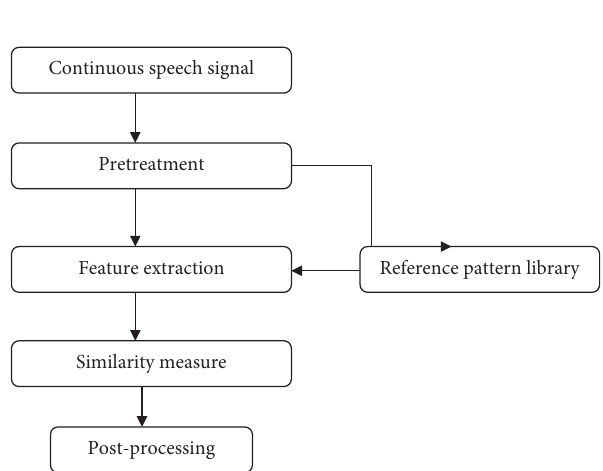
Figure 1: Pitch classification and recognition